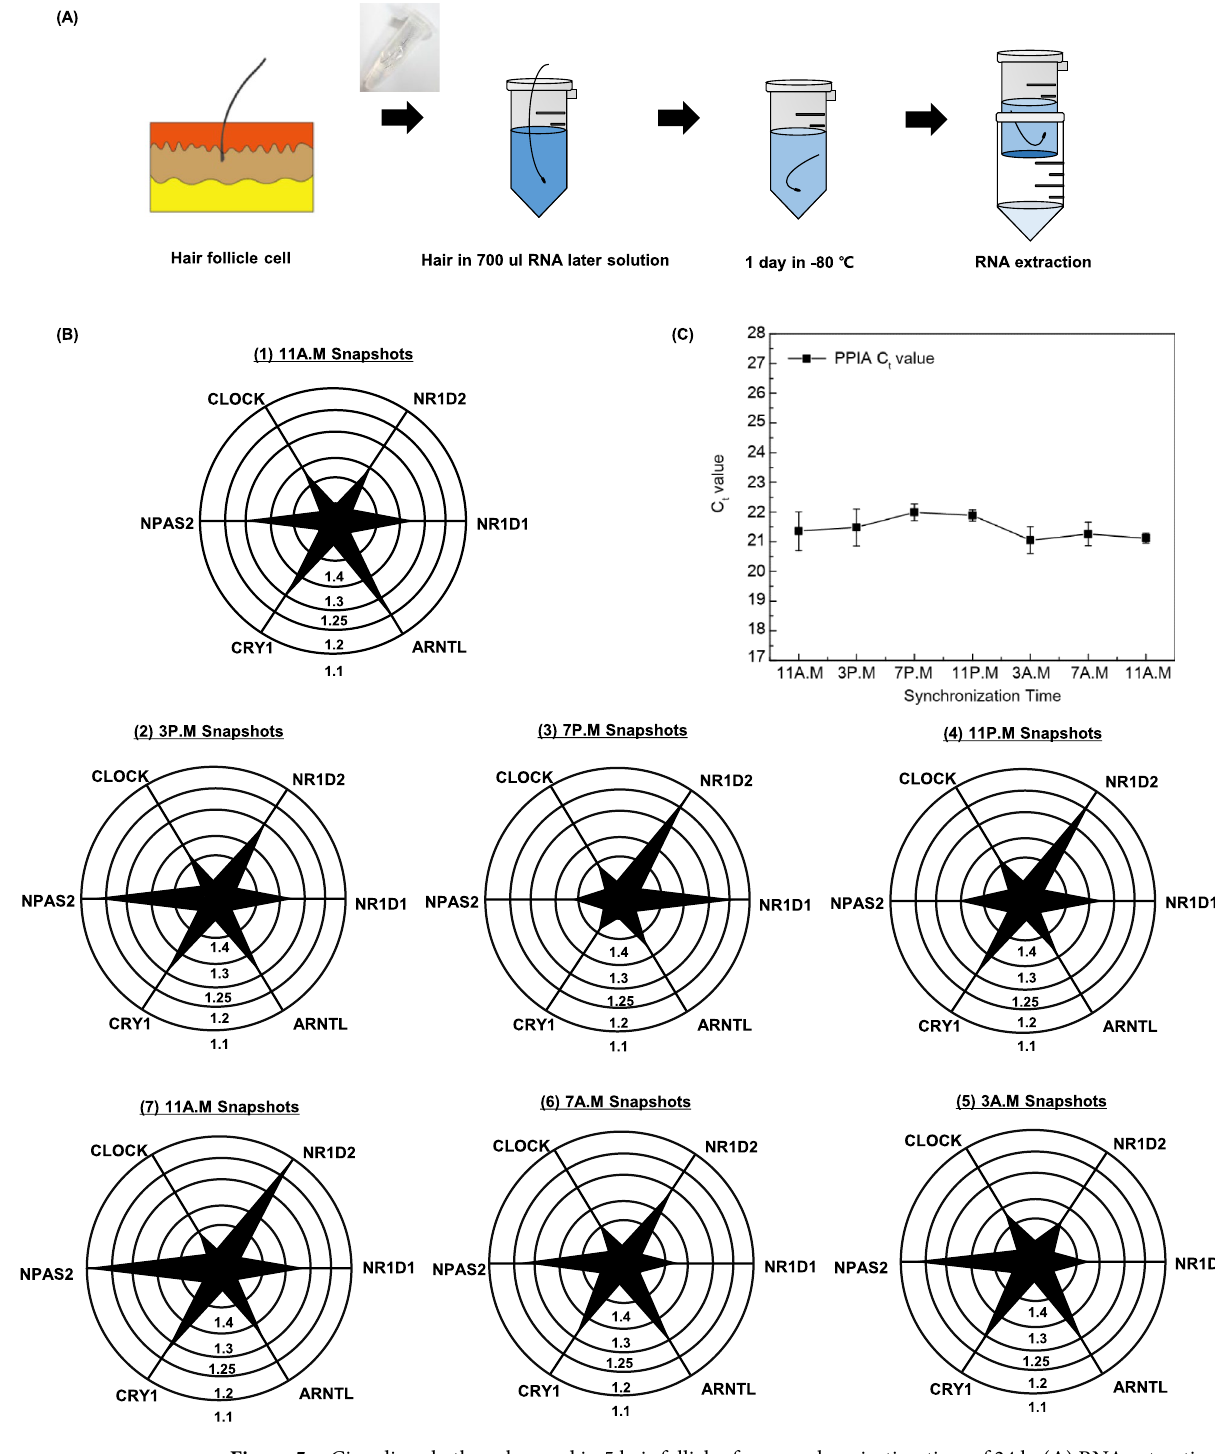
Figure 5. Circadian rhythm observed in 5 hair follicles for a synchronization time of 24 h. ( A ) RNA extraction procedure from the single individual with five different hair follicles Using total RNA collected from five different scalp hairs, real time one step RT-qPCR was performed to measure the expression of the genes. ( B ) Time course of expression profiles for each circadian gene for every 4 h starting from 11 A.M. for a total period of 24 h (n = 5) in radial graph. ( C ) Expression level of internal control (PPIA), for 24